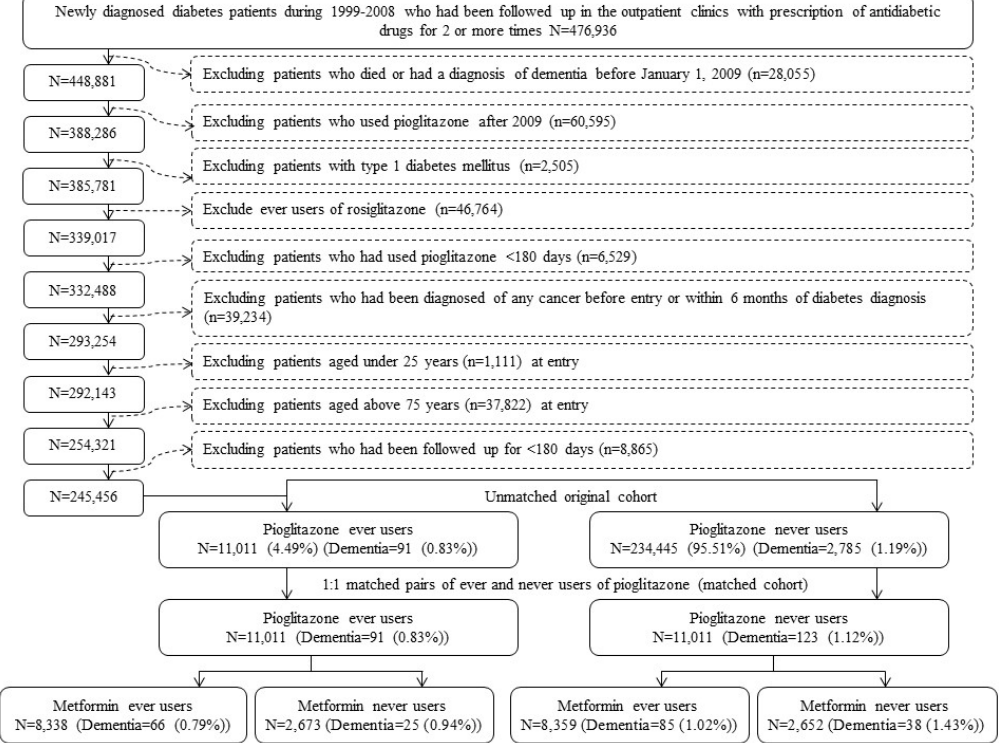
Figure 1. Flowchart for the procedures in selecting a propensity score matched cohort of pioglitazone ever users and never users.